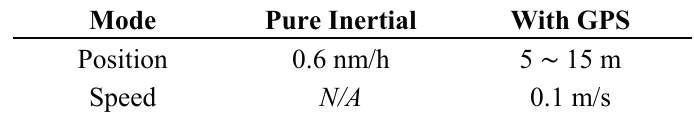
Table 6. The navigation accuracy of different modes for PHINS.